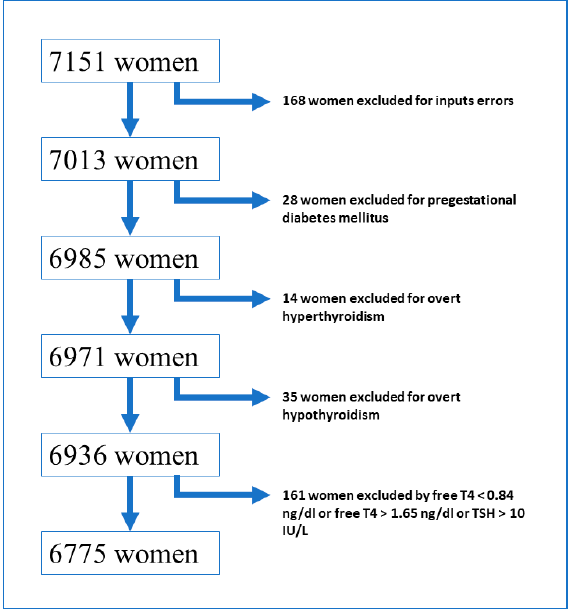
Figure 1. Selection algorithm for the study population; T4 = Thyroxine, TSH = Thyroid Stimulating Hormone.